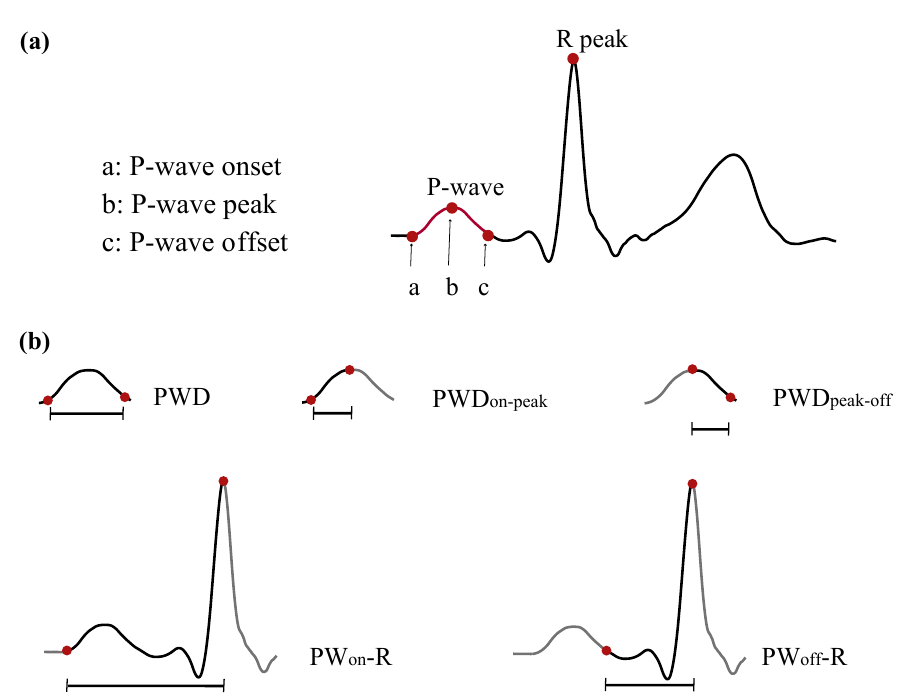
Figure 1. ( a ) Fiducial points of P-waves and R peaks. ( b ) Calculated temporal